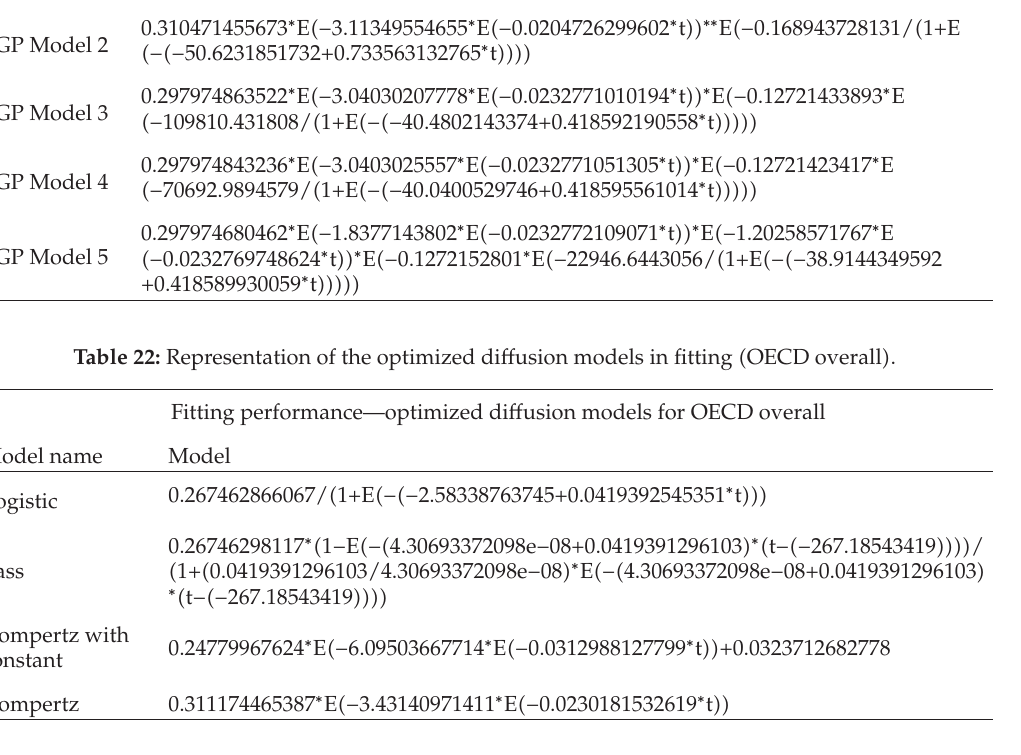
Table 23: Representation of the first five produced hGP models in fitting (cid:2) Sweden (cid:3) . Fitting performance—hGP models for